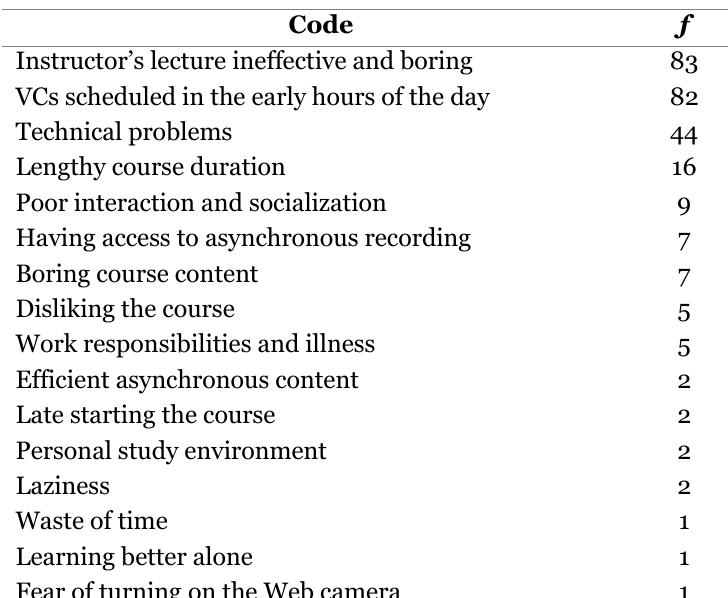
Table 2 Reasons for Not Attending VCs and Frequency of